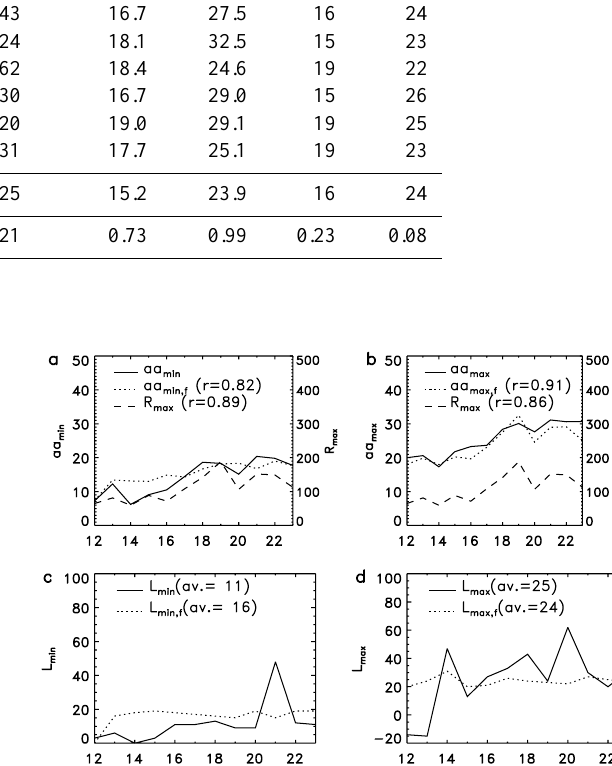
gether with the increasing trend in R z , aa min represents the geomagnetic activity generated by earlier solar